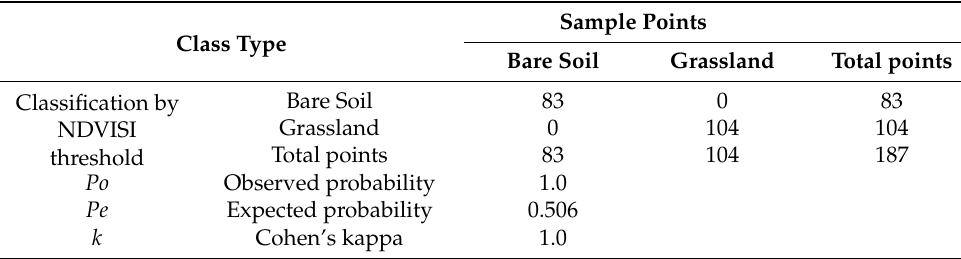
Table 6. Confusion matrix of “bare soil-grasslands” sample points classification with maximum Cohen’s kappa.